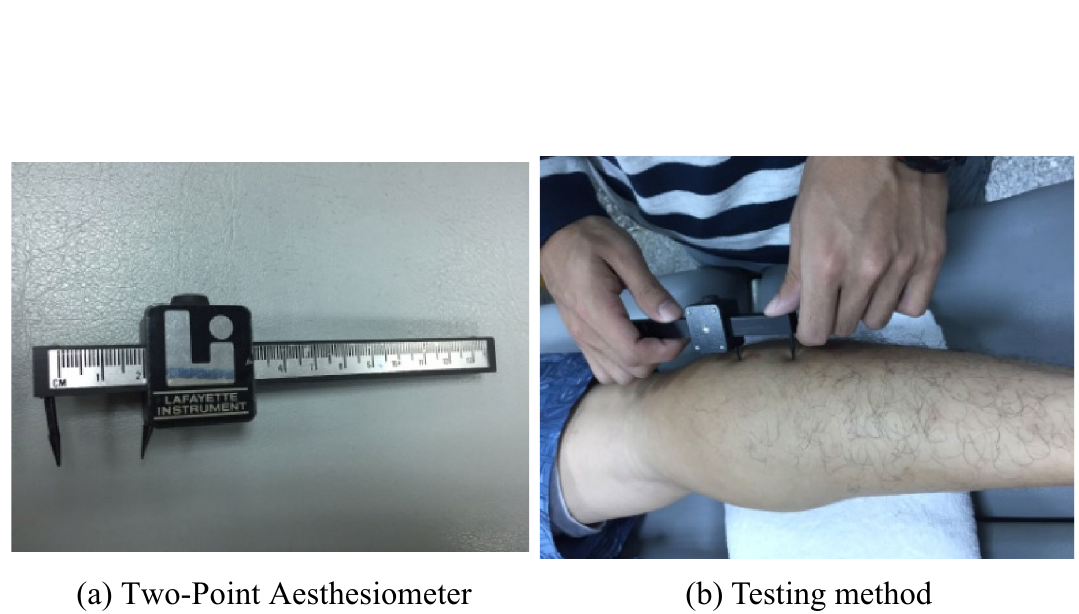
Figure 4. Device for combined cortical sensation test ( a ) the two-point aesthesiometer; ( b ) testing